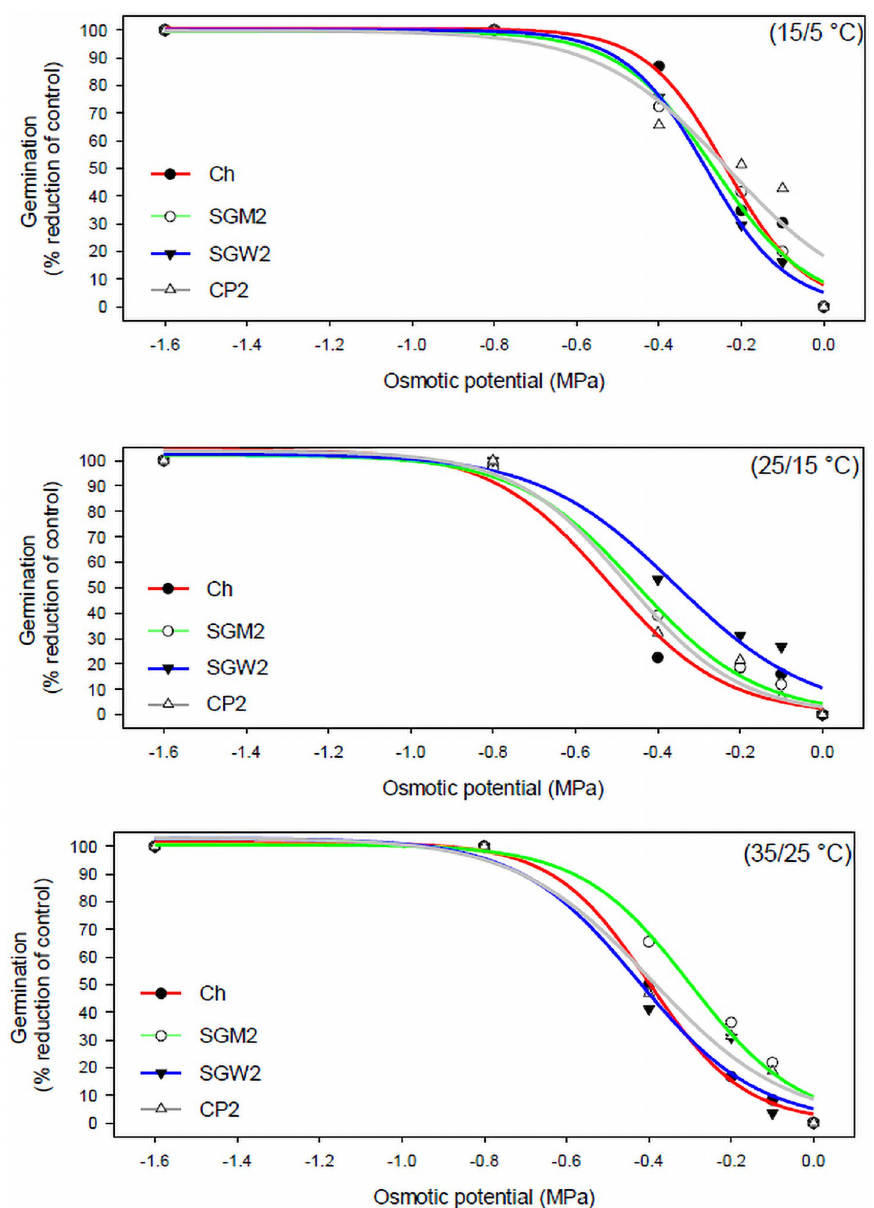
Fig 2. Monthly weather conditions of three locations from where the four populations of Chloris virgata were collected. (A) Monthly mean maximum and minimum temperature and (B) monthly mean rainfall. Ch was collected from Chinchilla; CP2 from Cecil Plains; and SGM2 and SGW2 from St George.